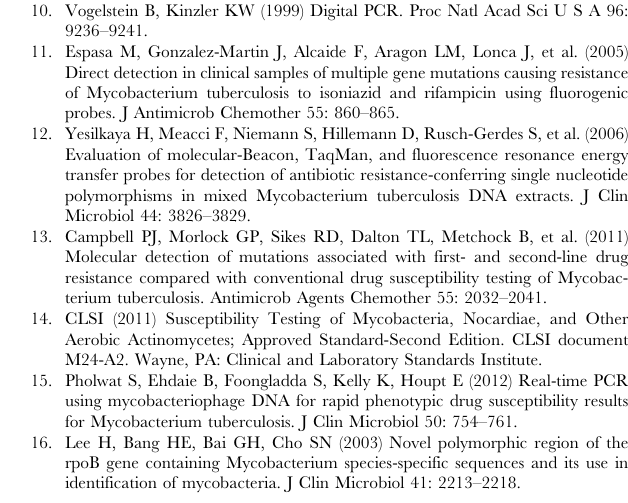
Figure S1 Real-time PCR of undiluted DNA. The undiluted DNA of each H37Rv:XDR-TB mixture underwent real-time PCR for each gene with both probes. rpoB, gyrA , and rrs are shown, with detection of mutant sequence (blue trace) at various H37Rv:XDR-TB mixtures. qPCR thresholds were set per Figure 1 (red and blue horizontal lines for wild-type and mutant fluorophores, respectively). (TIF) Table S1 Starting number and amount of cells in each PCR well for each diluted DNA template. (DOC) Table S2 Specificity of each probe versus non-tubercu- lous mycobacteria (NTM).